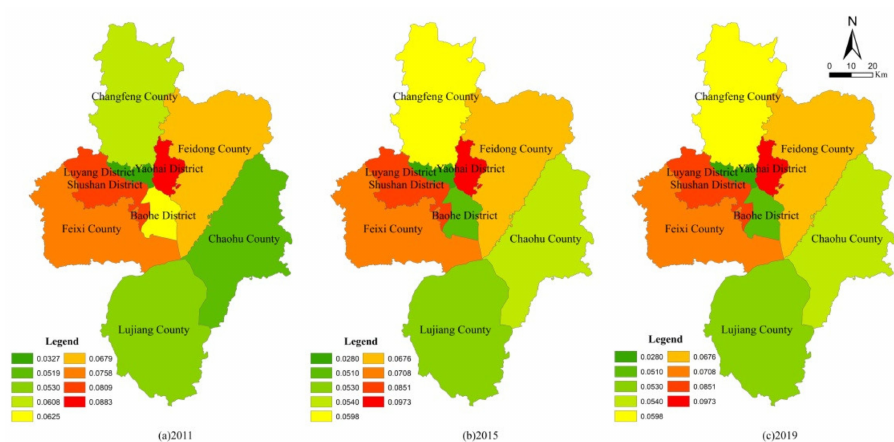
Figure 7. Ecological function evaluation results of districts and counties under carbon constraint.